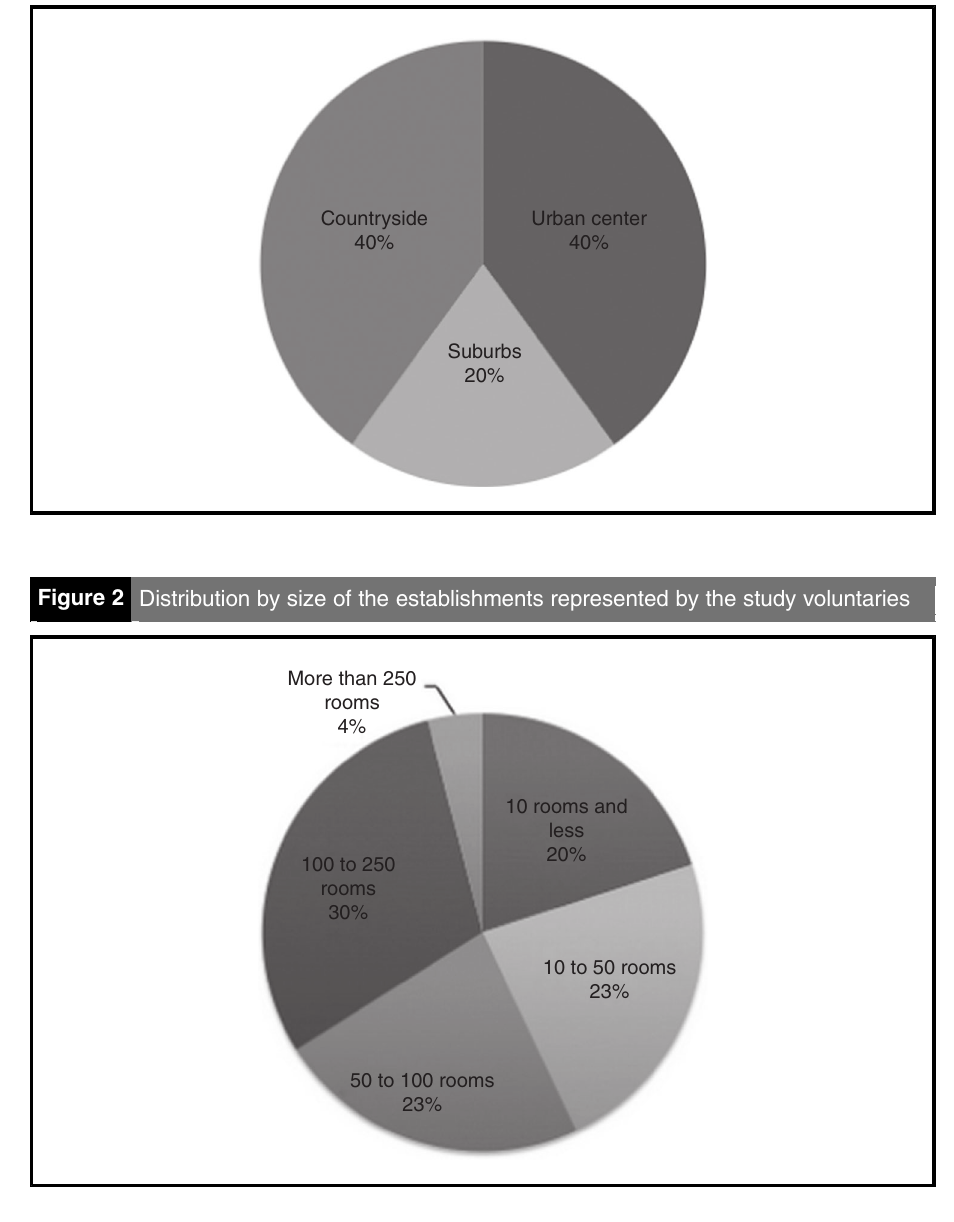
Figure 1 Distribution by location of the establishments represented by the study voluntaries